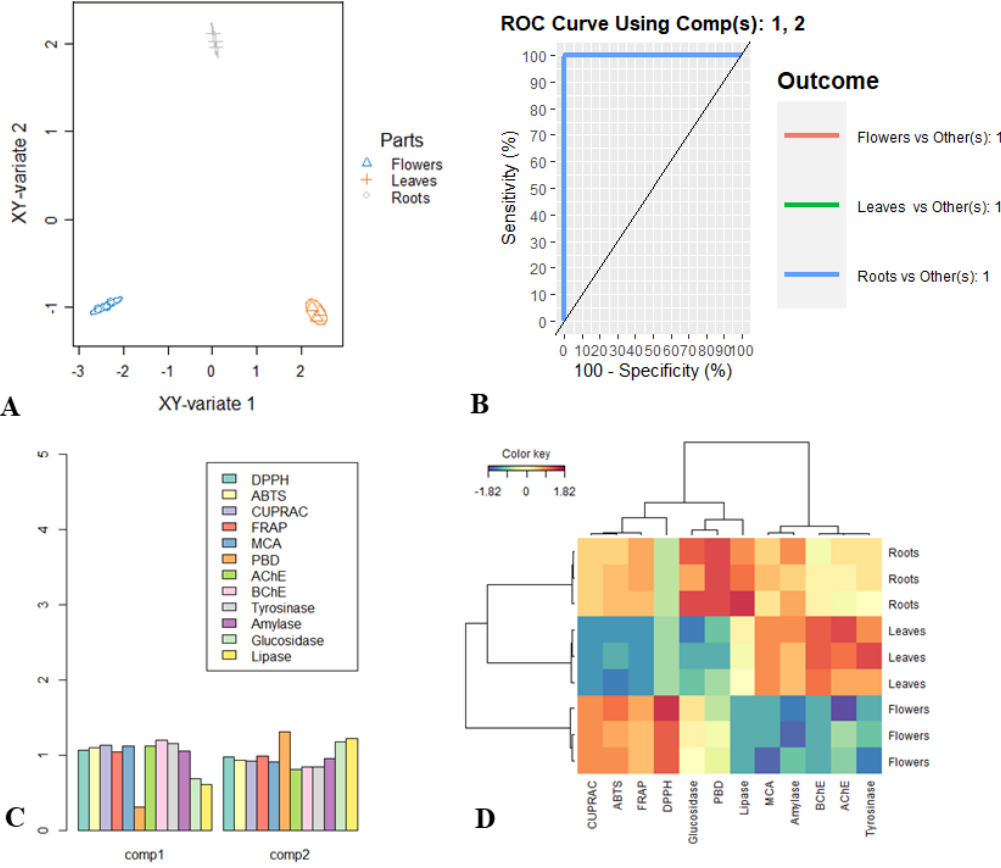
Figure 2. Partial Least-Squares Discriminant analysis graphical outputs on the biological activities of Tanacetum balsamita. ( A ) Samples plot. ( B ) ROC curve and AUC averaged using one-vs.-all comparisons. ( C ) The most discriminant biological activities identifying though VIP score calculation. ( D ) Clustered Image map (Ward linkage, Euclidean distance).